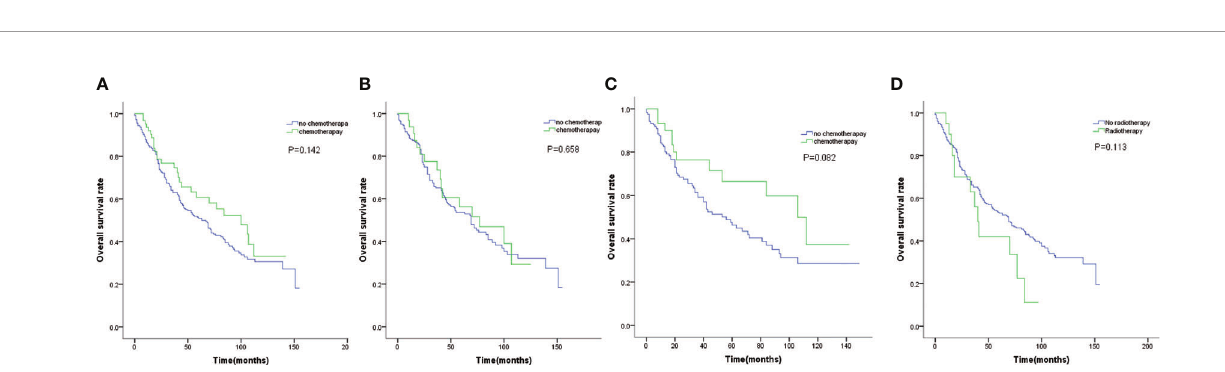
FIGURE 1 | (A) OS for patients by surgery type. (B) OS for patients with tumor size smaller than 2cm by surgery type. (C) OS for patients by lymph nodes dissection type. (D) OS for patients with tumor size smaller than 2cm by lymph nodes dissection type. (E) OS for patients with age ≥ 65 by surgery type. (F) OS for patients with age ≥ 65 by lymph nodes dissection